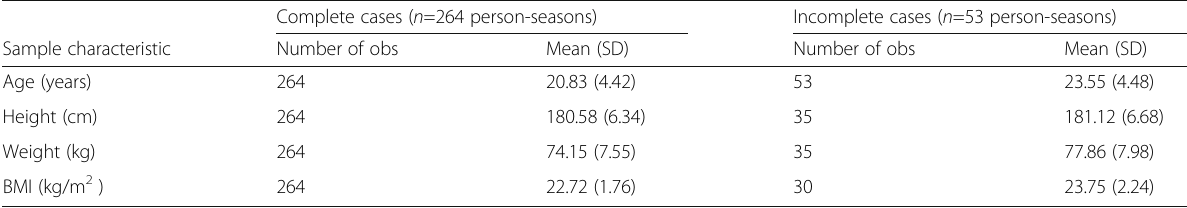
Table 2 Characteristics of cases with complete candidate prognostic factor data, and cases with at least one missing observation for any candidate prognostic factor in the PHE dataset with < 15% missing values